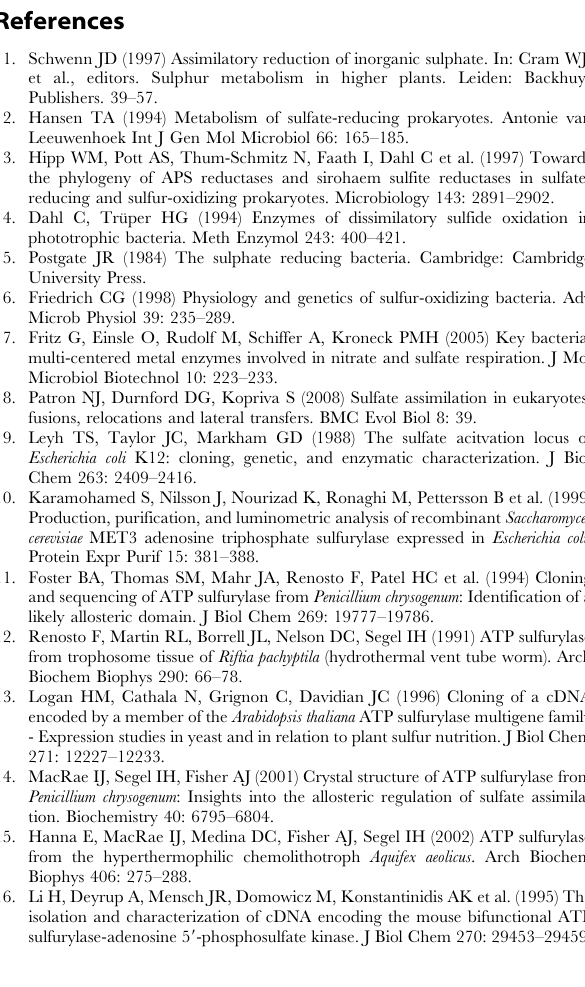
Figure S3 SDS–PAGE (10%) of recombinant A. vinosum ATP sulfurylase. The gel was stained with Coomassie brilliant blue. Protein purity was assessed after Nickel-chelate affinity chromatography (lane 1) and subsequent gel filtration